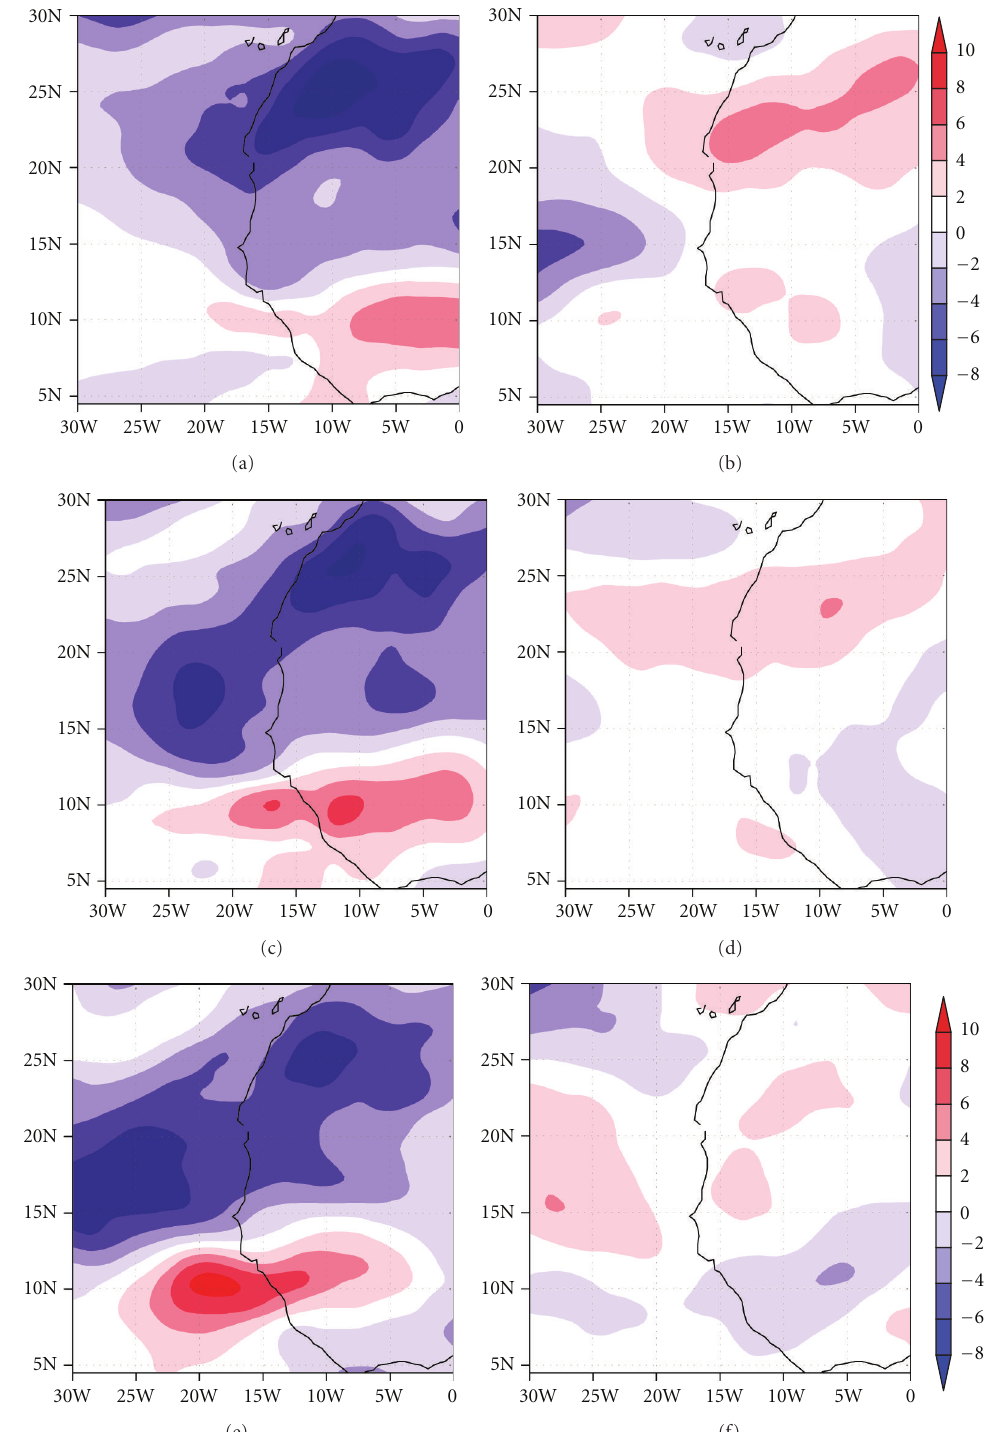
Figure 4: Similar to Figure 3 but for 600hPa zonal wind anomalies. Darker blues indicate larger easterly anomalies. slightly by 1-2 m s − 1 with continued weakening 12 hours speeds 7-8 m s − 1 weaker than the TCP case during the 6–12 after the event has passed the NPOL location. In relation to hours prior to the convective event. As the AEW passes, the the AEW, the AEJ remains strong as it moves o ff the coast, wind speeds remain fairly constant near the NPOL location. increasing to values in excess of 16 m s − 1 as it begins to move The AEJ begins to weaken as it moves o ff the coast as well, over the eastern Atlantic. The NTCP case shows zonal wind signifying weaker easterly winds than seen with the TCP